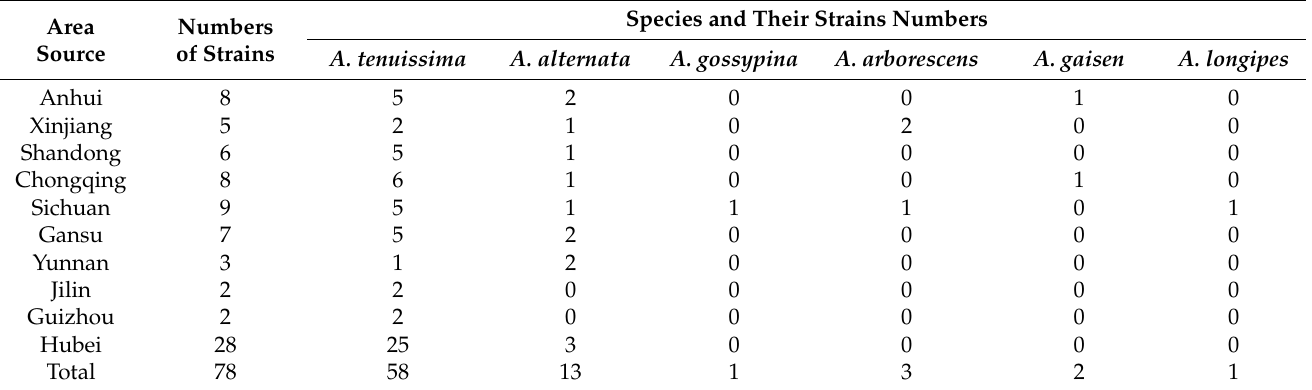
Table 1. Origin of the strains of Alternaria species used for high-throughput sequencing in this